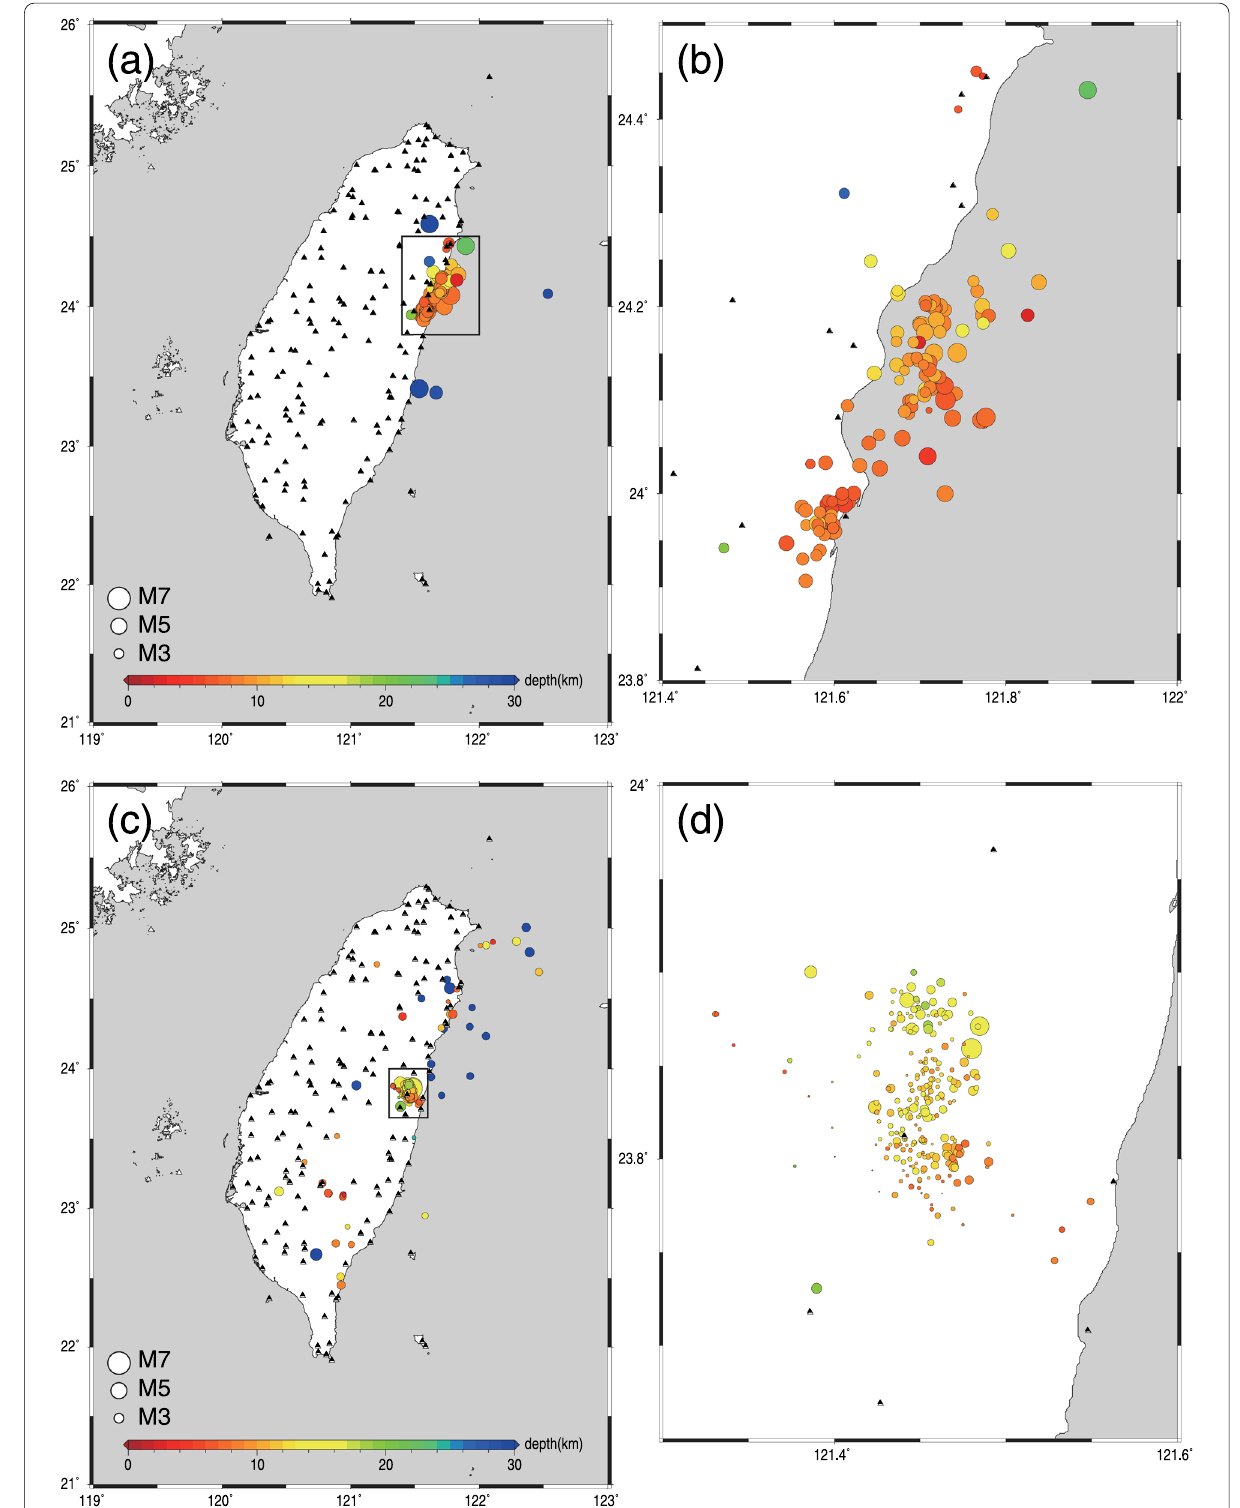
Fig. 1 Map of the stations (black triangles) and earthquakes (circles) ( a ) Earthquakes with an observed SI rectangle in ( a ). c All earthquakes in the CWB manual catalog on Apri 18, 2021. d Close‑up of the rectangle in ( c